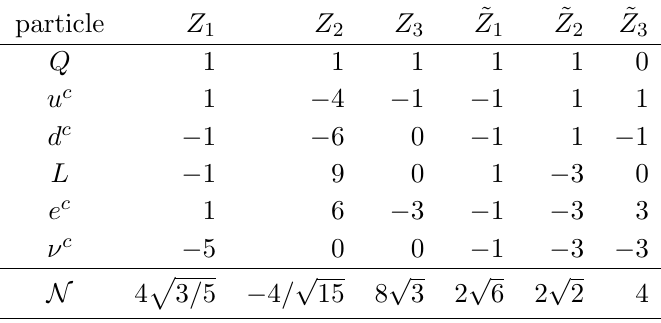
Table 2 . The charges q of di(cid:11)erent VEV alignments Z of the 210 on